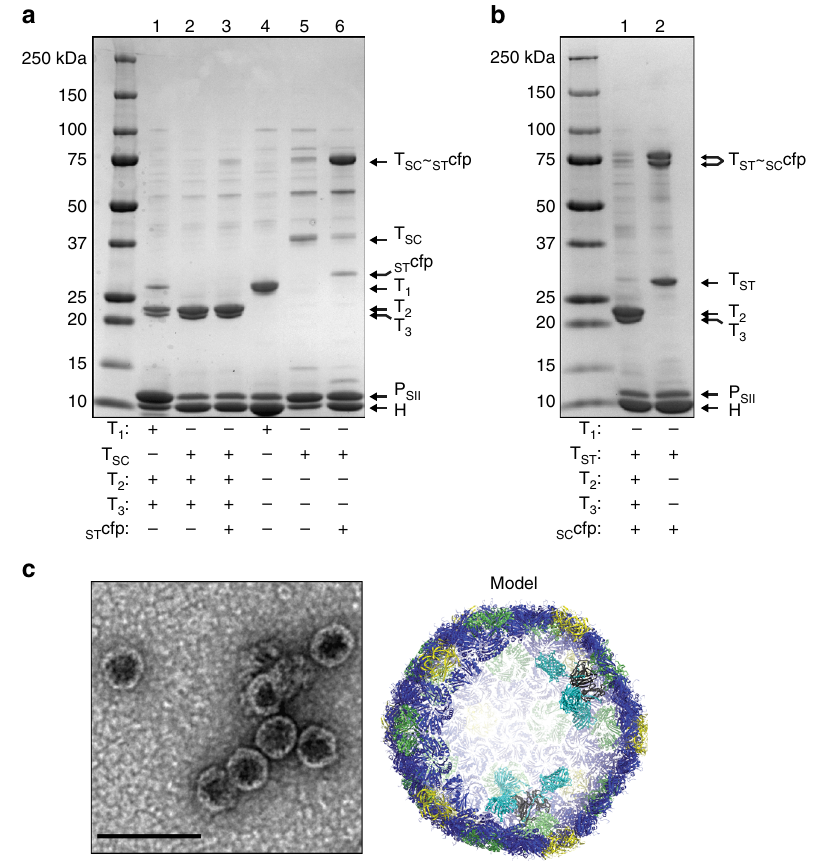
Fig. 4 SDS-PAGE and electron micrographs of various shell preparations. a , b SDS-PAGE of shell preparations. Composition of shell preparations given in tabular form below each lane. c Negative stain TEM of HT SC ~ ST cfpP SII shell preparation (lane 6 in fi gure a ) and cutaway model of shells (cfp rendered in turquoise, not completely functionalized for clarity). Results presented are representative of at least two independent biological replicates of each sample